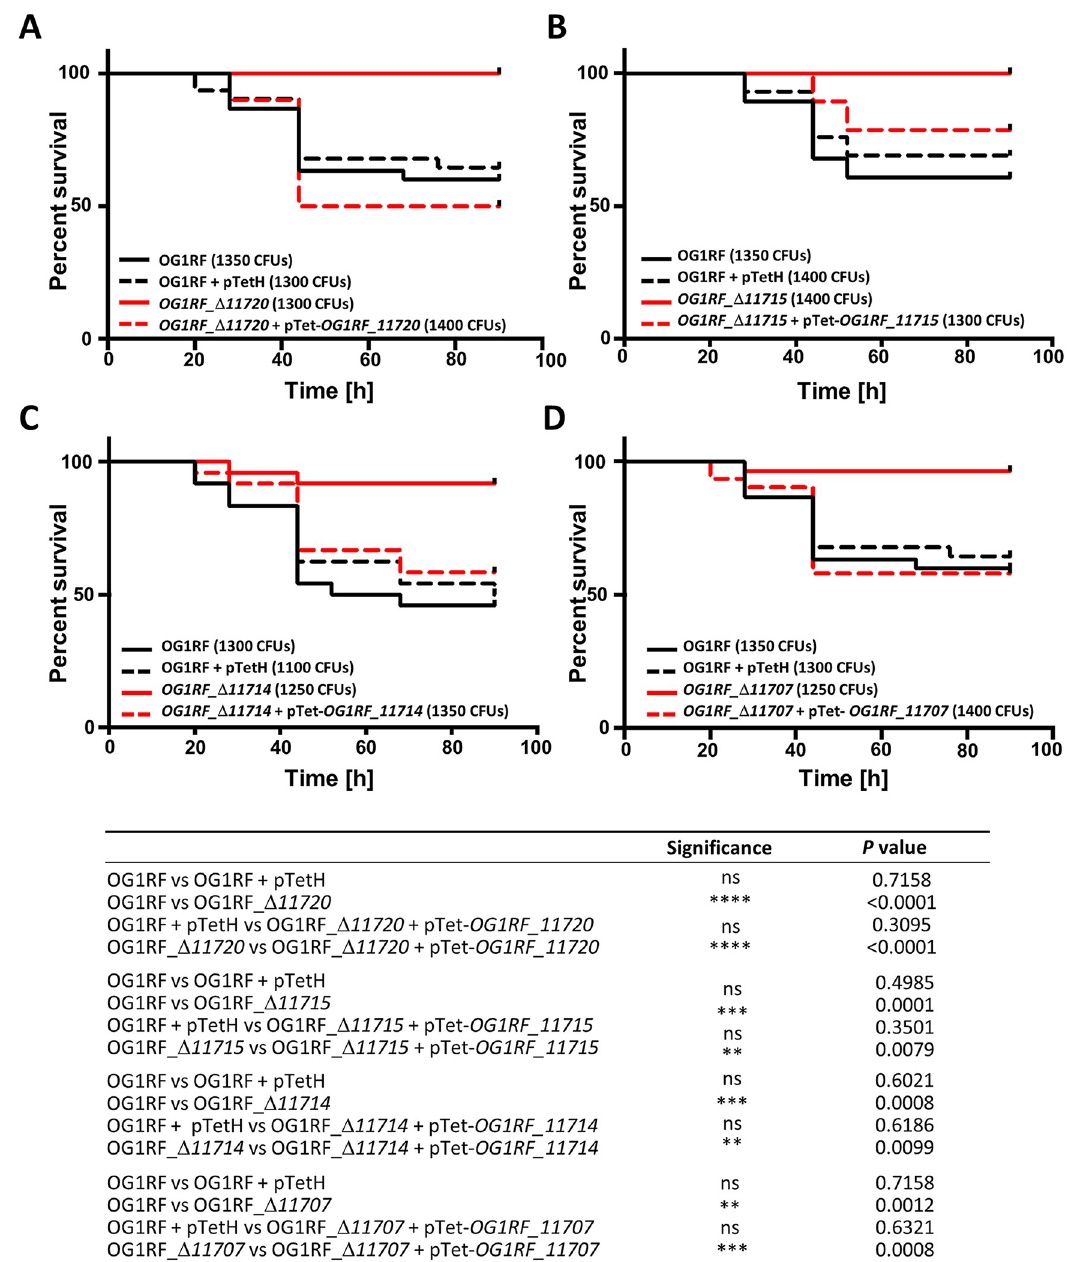
Fig 7. Virulence of epa mutants and complemented strains in the zebrafish model of infection. Survival of zebrafish larvae (n > 20) following infection with E . faecalis OG1RF (WT) and epa deletion mutants was monitored over 90 h post infection. A . Mutant Δ 11720 . B . Mutant Δ 11715 . C . Mutant Δ 11714 . D . Mutant Δ 11707 . E . Statistical significance determined by Log-rank test; ns, P > 0.05; �� P < 0.01; ��� P < 0.001; ���� P < 0.0001. All injections presented in Fig 4A and 4D were carried out on the same day. The same data corresponding to the OG1RF strain are therefore shown for the 2